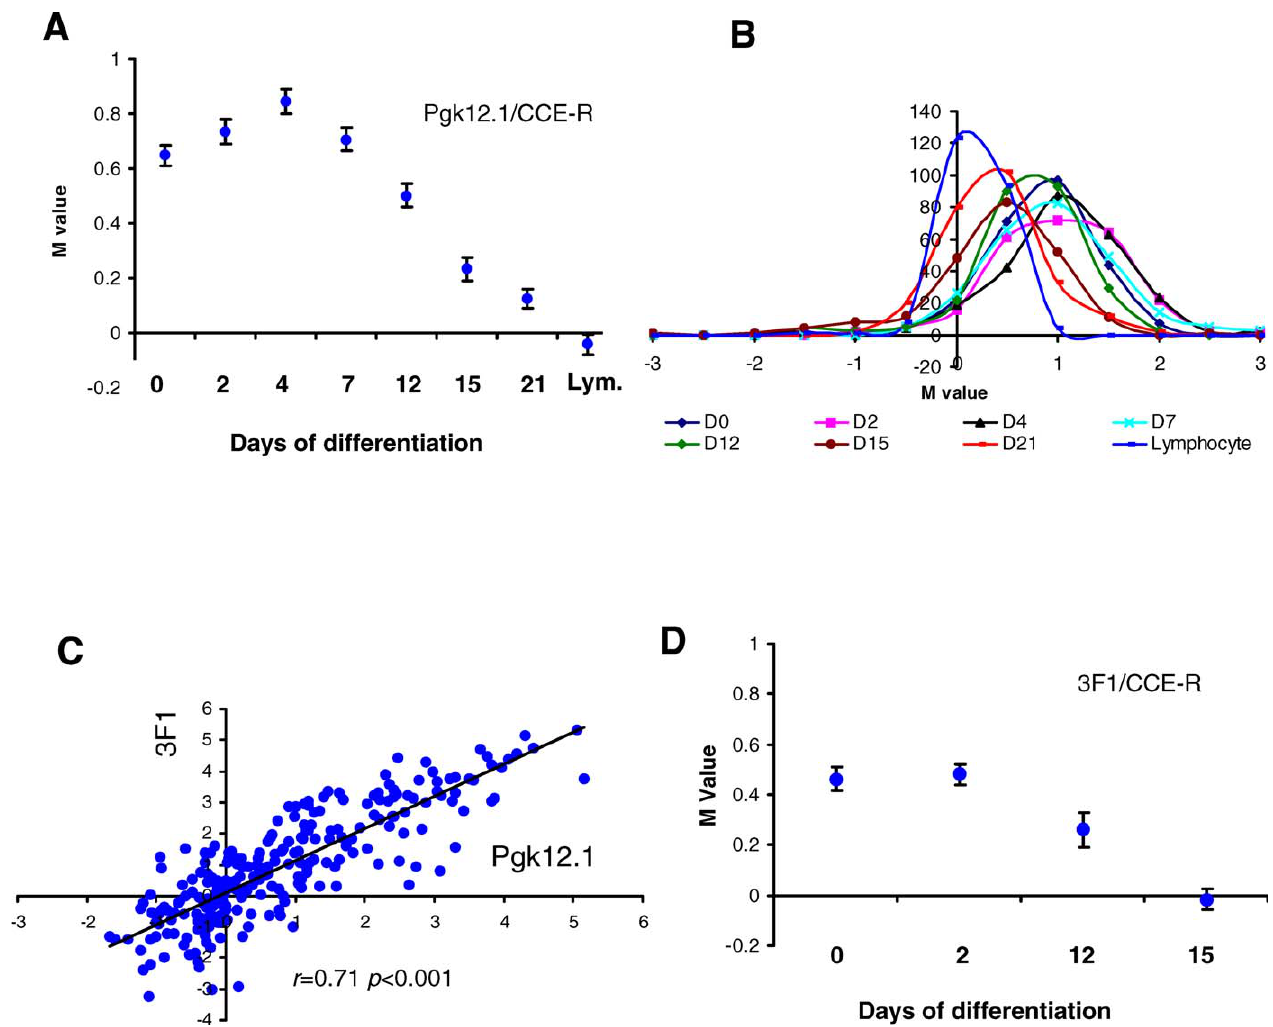
Figure 4. A Fall in X-Linked Gene Expression in Female ES Cells Is Detected Late in Differentiation (A) M values (female:male expression ratio, log 2 scale, 6 SE) for X-linked genes in PGK12.1 female ES cells at different times of differentiation (days 0–21). The fall in M value is attributable to the progressive inactivation of genes on one of the two female Xs. Biological replicates for PGK12.1 cells are as listed in Figure 3A. (B) Distribution of M values in PGK12.1 ES cells at different days of differentiation (day 0, day 2, etc., as indicated) and adult lymphocytes. All distributions are normal with a progressively decreasing median. (C) Correlation in expression levels of X-linked genes between 3F1 ( y -axis) and PGK12.1 ( x -axis) ES cell lines. The value for each X-linked gene is expressed relative to the expression of autosomal genes (X:A ratio, log 2 scale). Pearson product moment correlation coefficient ( r value) and FDR- corrected probability of chance correlation ( p ) are shown. (D) M values (female:male expression ratio, log 2 scale, 6 SE) for X-linked genes in 3F1 female ES cells at different times of differentiation (days 0, 2,